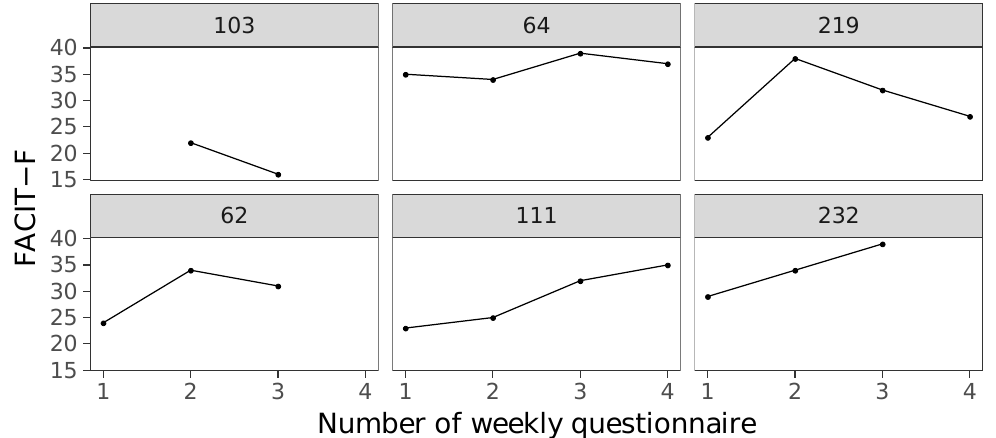
Figure 6. The course of FACIT-F weekly reports over the study period for all patients. Each subfigure represents one patient.